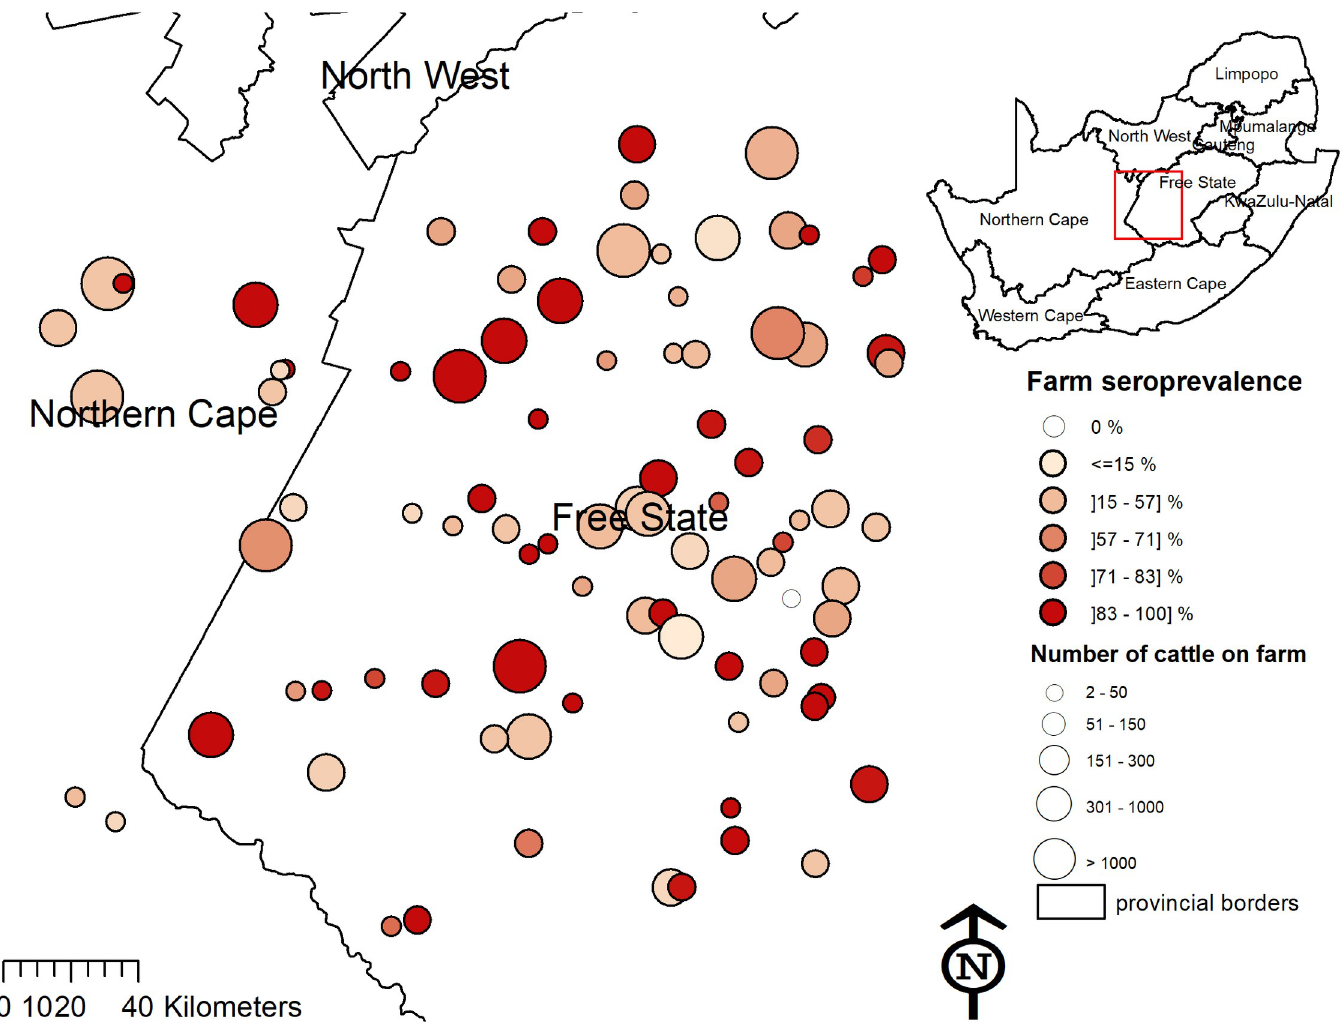
Fig 4. Seroprevalence of Crimean-Congo haemorrhagic fever virus antibodies amongst cattle on farms in Free State and Northern Cape provinces. Size of circle indicates the number of cattle on the farm and colour indicates farm-level seroprevalence. The map was constructed for the manuscript in Esri ARCGIS 10.2 using country and provincial boundaries from Municipal Demarcation Board [23] and National Geo-Spatial Information [24], coordinates of sampling sites and towns collected during the survey data available under a Creative Commons Attribution (CC BY 4.0) license.